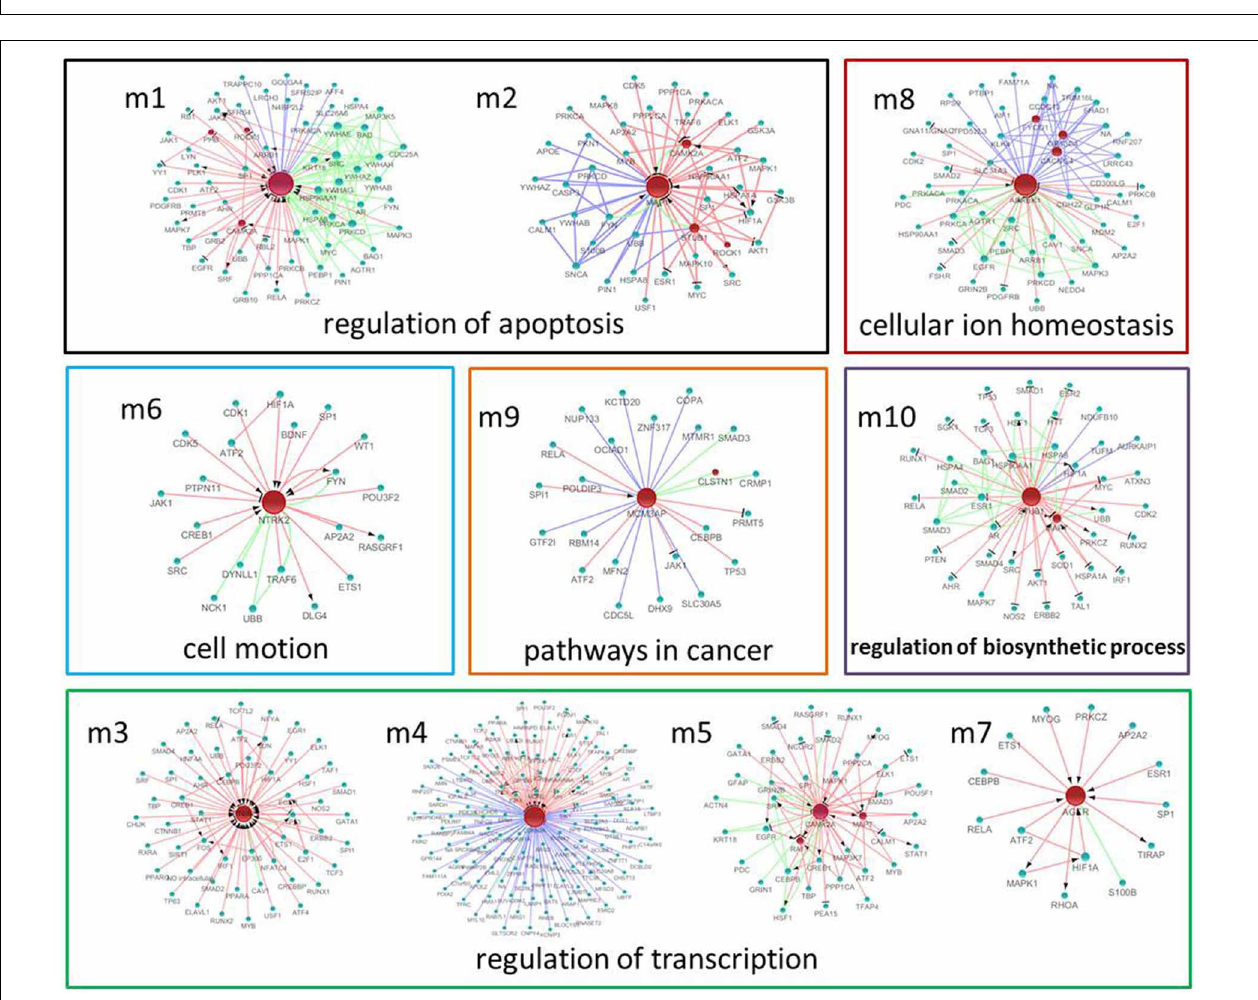
FIGURE 6 | The significant modules and nodes of genetic sub-network in the brain of SAMP8 mice. Red nodes are differential expressed genes in SAMP8 mice, and green nodes are intermediate genes. The genes are linked with red line if they have interaction in